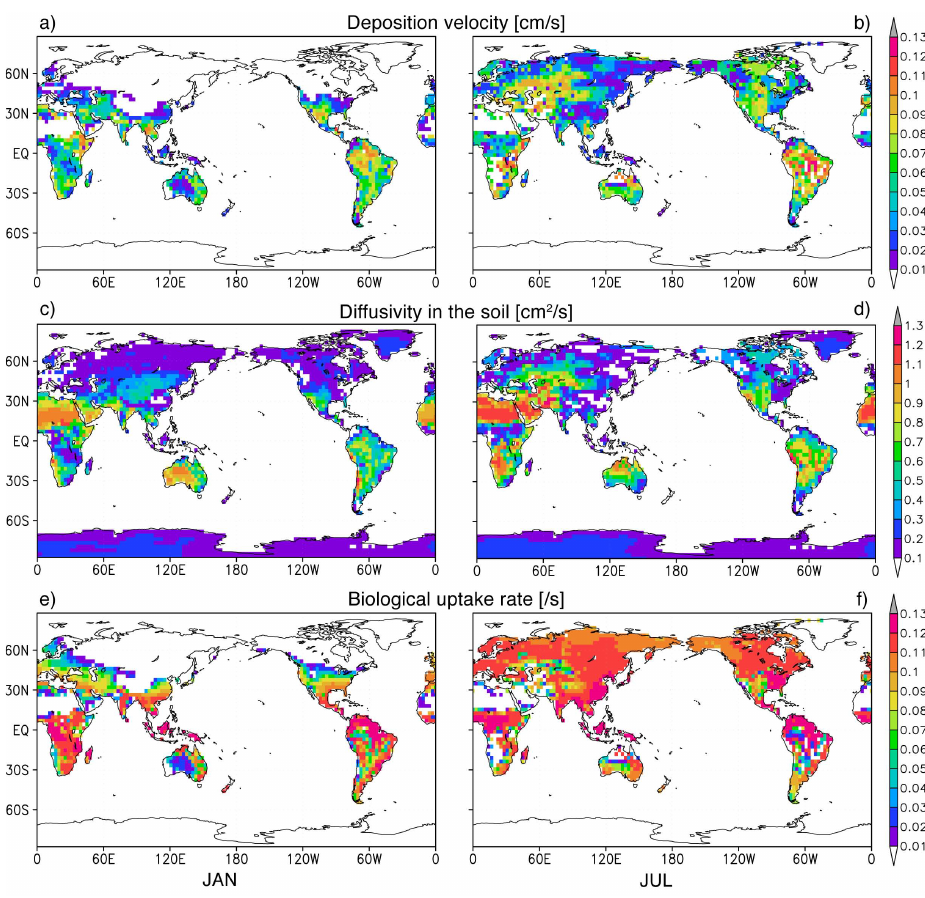
Fig. 1. Monthly mean distribution of simulated deposition velocity (a, b) , diffusivity in the soil (c, d) , and the uptake rate of biological H 2 -consumption (e, f) for January and July. The values are averaged over the period